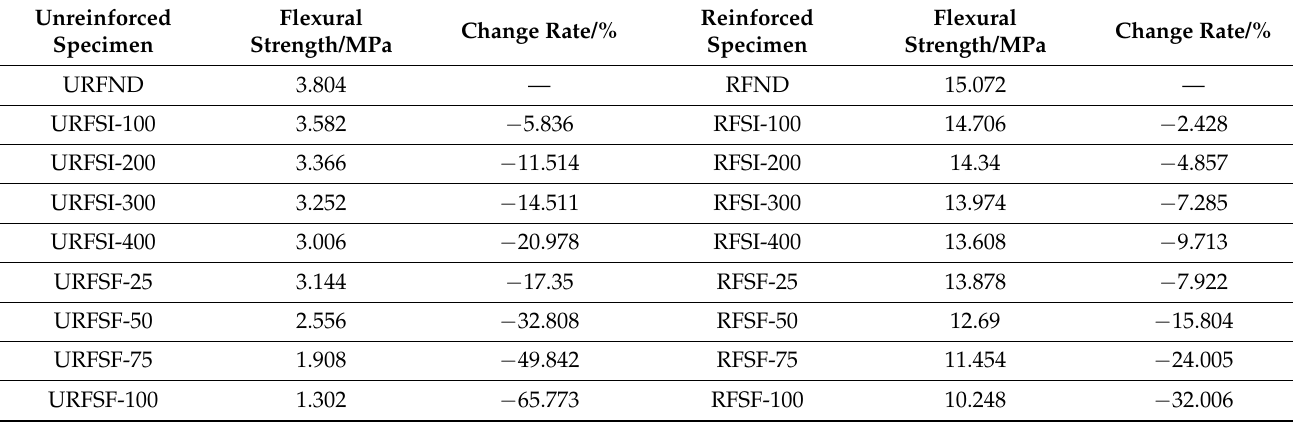
Table 8. Flexural strength of concrete flexural specimen.